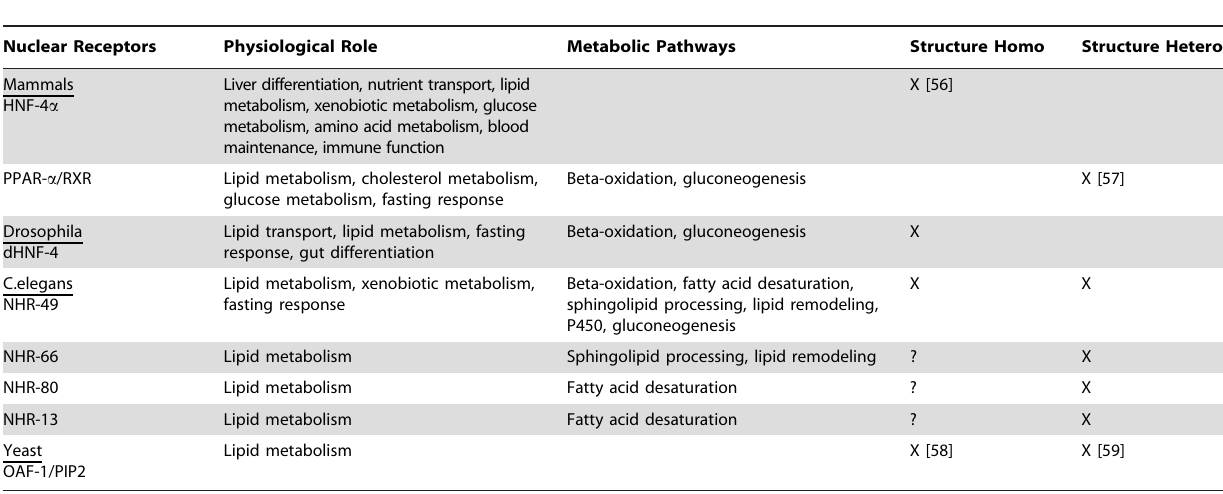
Table 3. Insights on the evolution of the HNF4 family across